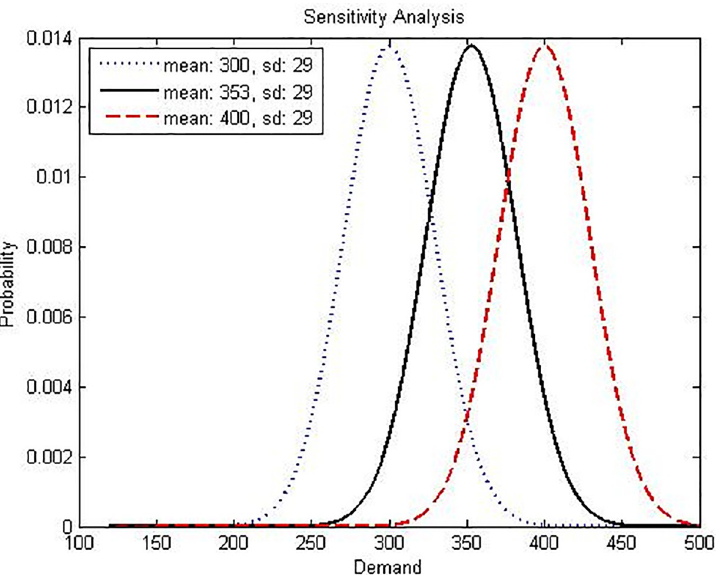
Fig 7. Graphical interpretation of the sensitivity analysis for Model-I varying mean parameter for the random variable demand. Own